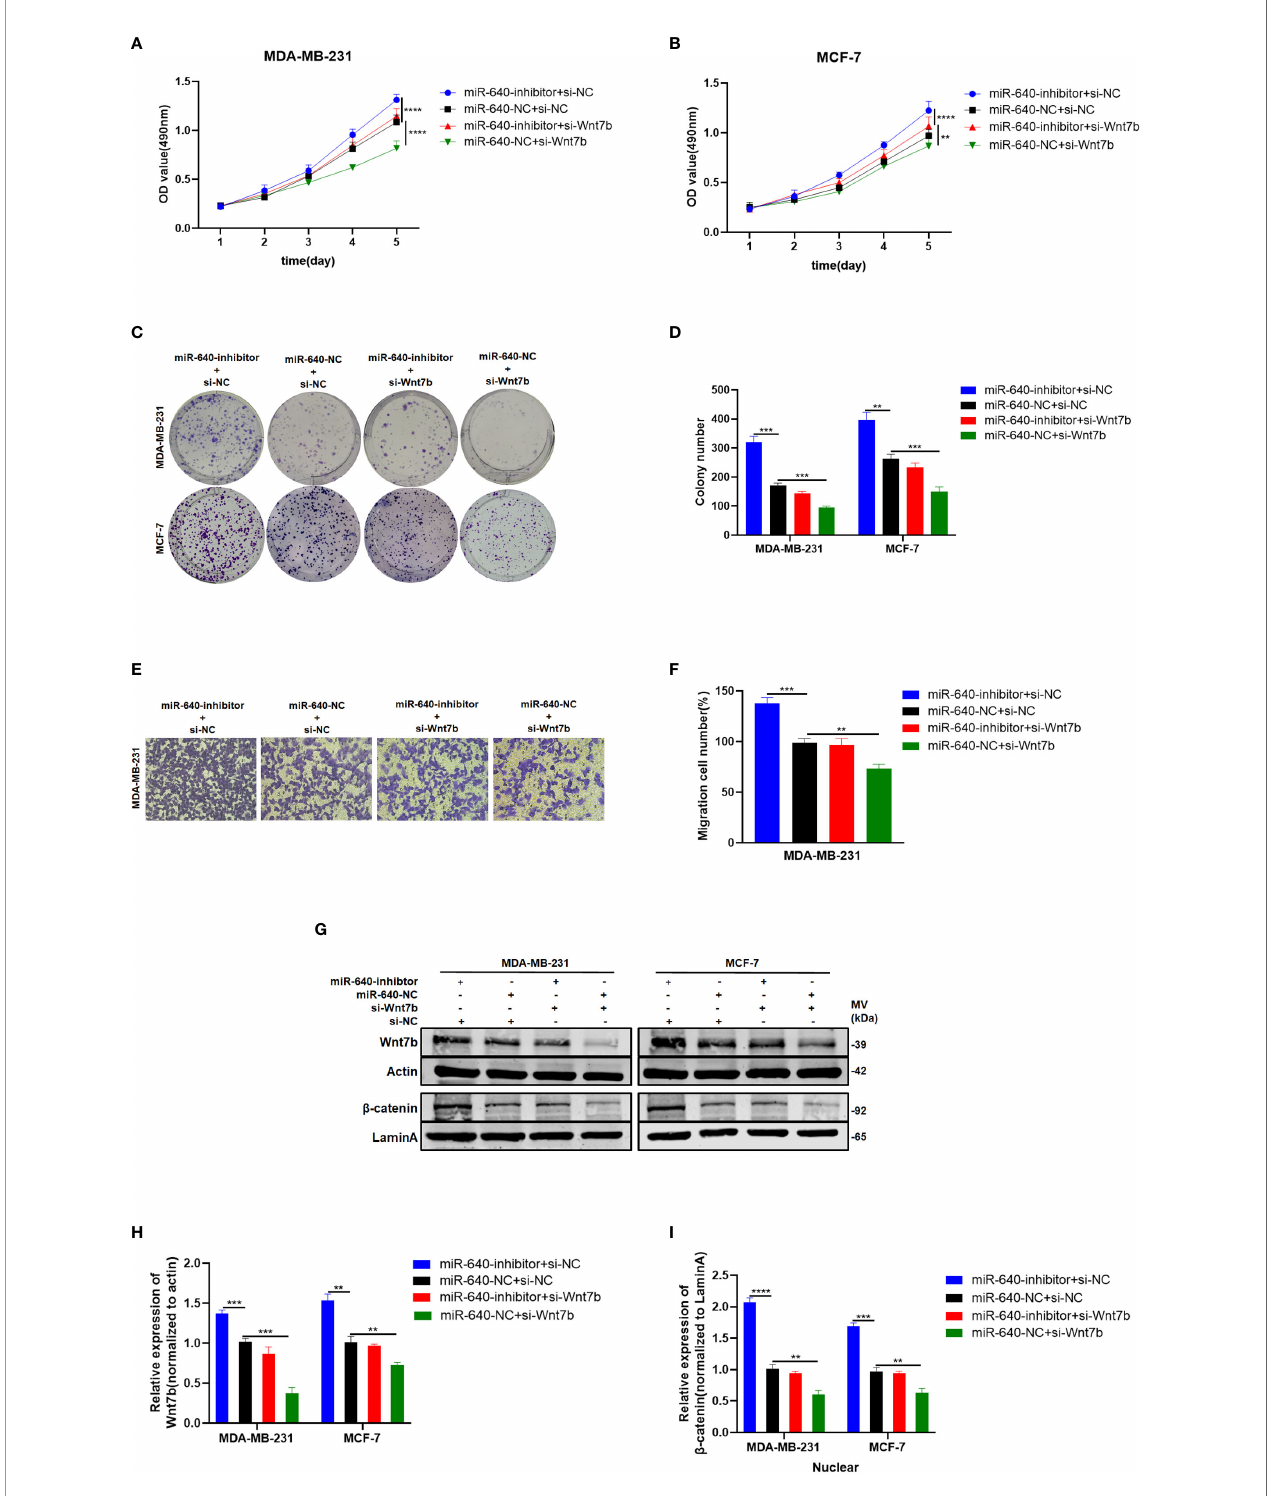
FIGURE 5 | Depletion of Wnt7b rescued the effect of miR-640-inhibitor on BC cells. (A – D) Knockdown of Wnt7b partially reversed miR-640-inhibitor-induced promotion of proliferation in MDA-MB-231 and MCF-7 cells determined by MTT assay and colony assay. (E, F) Knockdown of Wnt7b partially reversed miR-640- inhibitor-induced promotion of migration in MDA-MB-231 and MCF-7 cells determined by transwell assay. (G – I) Western blotting analysis for Wnt7b/ b -catenin protein level in MDA-MB-231 and MCF-7 cells. **p < 0.01, ***p < 0.001, ****p <